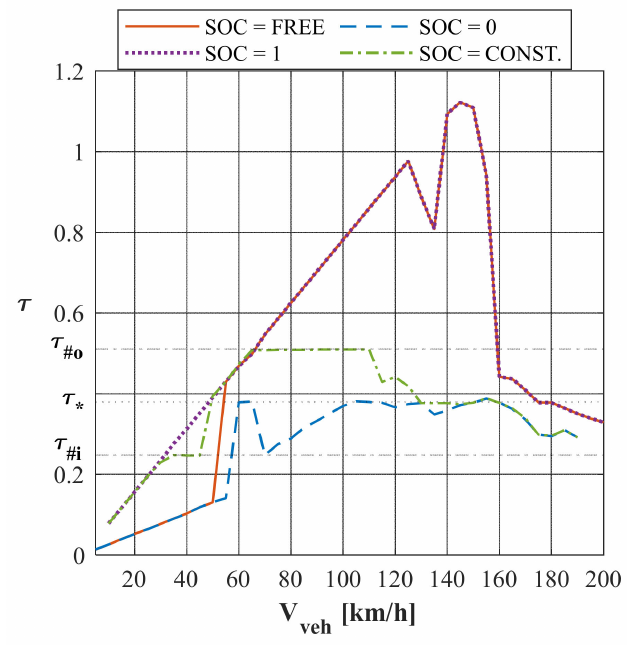
Figure 11. Optimal overall transmission ratio and mode selection in power-split